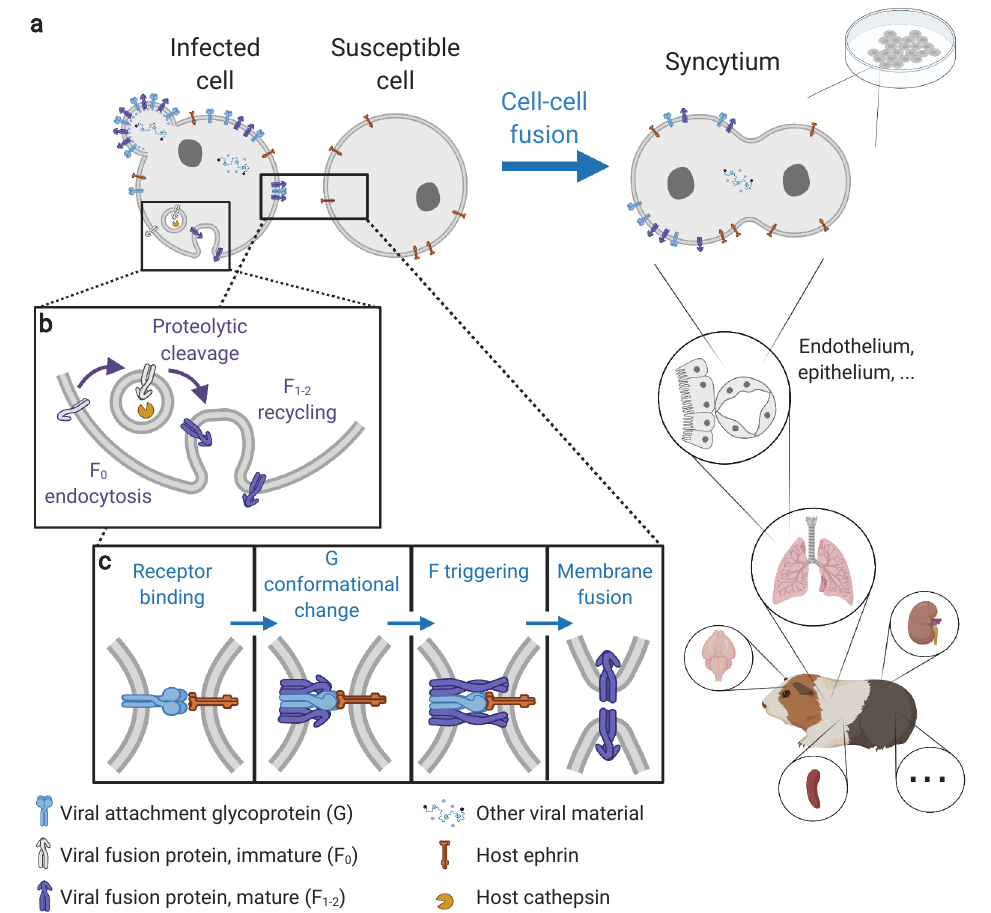
Figure 1. Molecular mechanisms and cellular manifestations of henipavirus-induced syncytium formation. ( a ) Syncytia are multinucleated cells formed from the fusion of an infected cell with a susceptible cell. Syncytia can be observed both in vitro (in cell culture) and in vivo (here in a Guinea pig). In vivo, syncytia are observed in a wide range of tissues, including the vascular, respiratory, nervous, lymphatic, and urinary systems, particularly (but not exclusively) at endothelial and epithelial interfaces. Syncytia can occur both between infected and non-infected cells, and between infected cells. ( b ) Fusion protein maturation via the proteolytic activation by host cathepsins in endosomes. ( c ) Membrane fusion cascade via the interactions between viral envelope proteins (G and F) and host receptors (ephrins). Membrane fusion is a pH-independent process using an attachment-mediated triggering mechanism of the fusion protein. Steps preceding membrane fusion (in particular infection, viral replication, and viral protein expression and egress) are detailed in Howley and Knipe 2020 [46]. Visual created using BioRender.com on 21 August